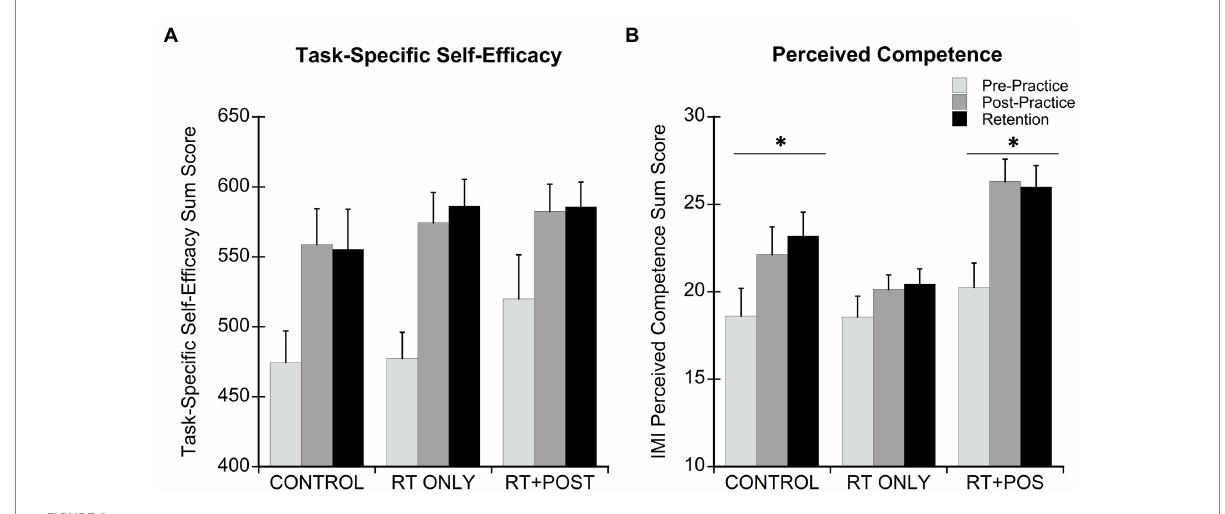
FIGURE 4 (A) Task-Specific Self-Efficacy Scores ± standard deviation for each group at pre-practice, post-practice, and retention . (B) Intrinsic Motivation Inventory (IMI) Perceived Competence subscale sum scores ± standard error for each group at pre-practice, post-practice, and retention. Maximum scores for the IMI Perceived Competence subscale is 35. * Significant main effect of time within